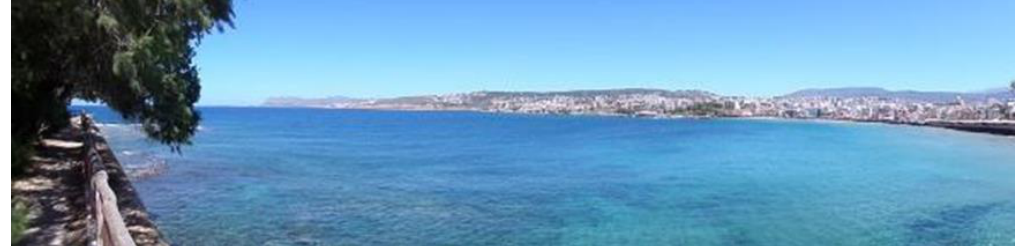
Figure 3. Typical view from the east part of the Old Port of Chania, island of Crete: the sound environment is mainly determined by background noise from the city, local car traffic, people talking, and sounds of the nature (wind in the trees, sea, birds, etc.).